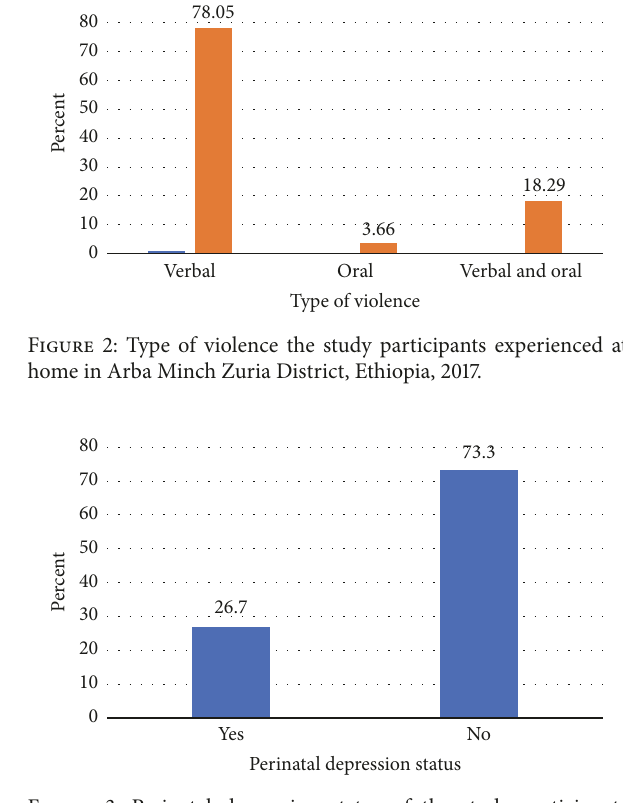
Mothers who are unable to read and write had